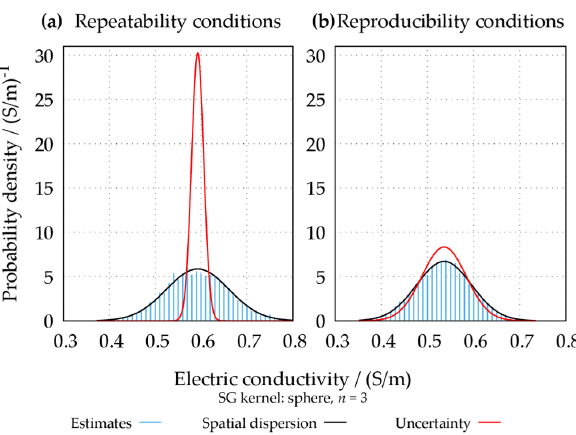
Figure 7. Comparison between the statistical distribution of the estimated mean electric conductivity values, their spatial dispersion, and their average voxel ‐ wise uncertainty. The spatial dispersion is represented through a Gaussian curve with the same mean and standard deviation as the estimates. The uncertainty is represented through a Gaussian curve with the same mean as the estimates and the standard deviation equal to the average of the uncertainties associated with each estimate. The comparison is reported both for repetitions ( a ) and reproductions ( b ).